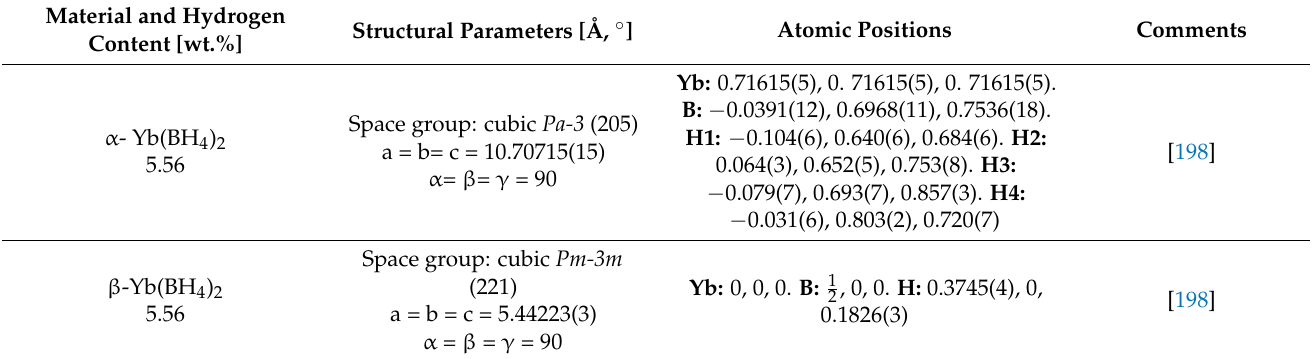
Table 17. Crystal structures of